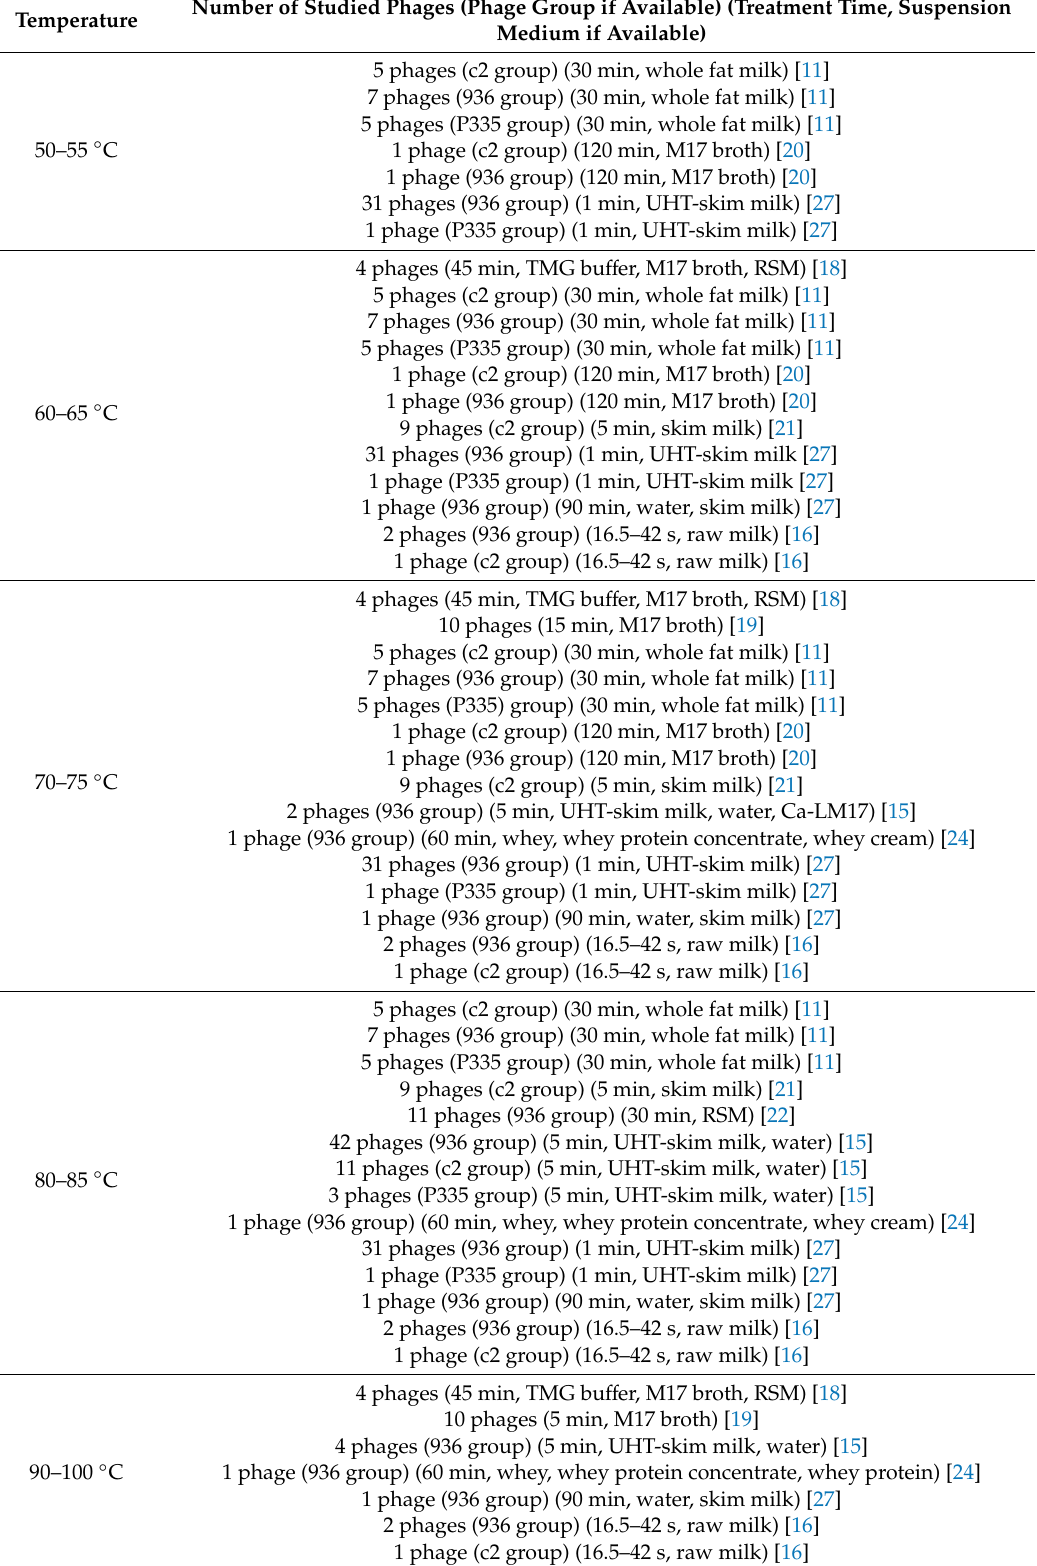
Table 1. Thermal treatments (temperature, time, suspension medium) studied for inactivation of lactococcal